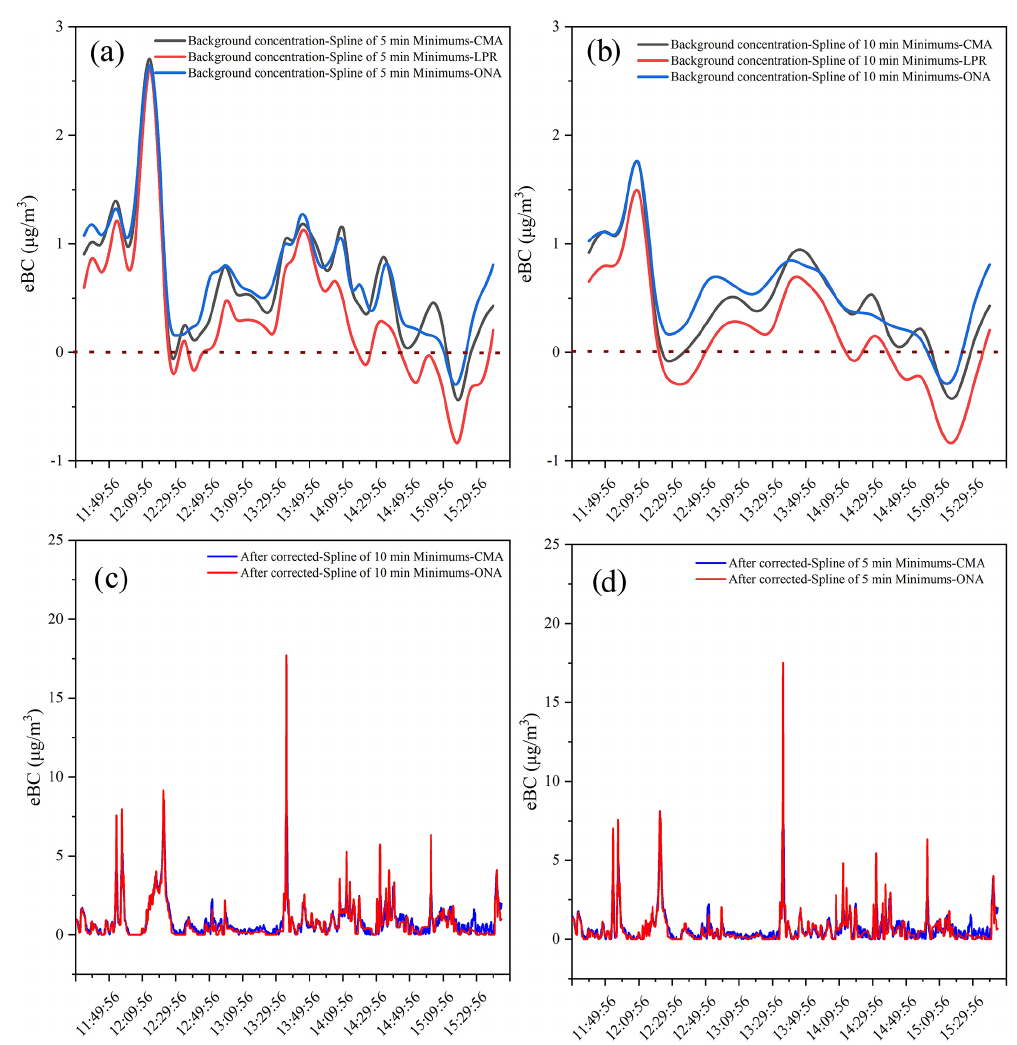
Figure 3. Background concentration of black carbon under different time series for (a) spline of 5min minimums and (b) spline of 10min minimums and after being corrected for (c) spline of 5min minimums and (d) spline of 10min minimums. Analyses are based on measure- ment